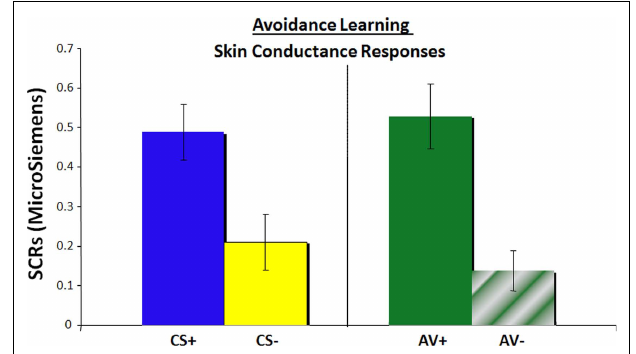
FIGURE 2 | Physiological measure of conditioned fear, as assessed by skin conductance responses, representing arousal responses during the CS phase for all four types of trials.